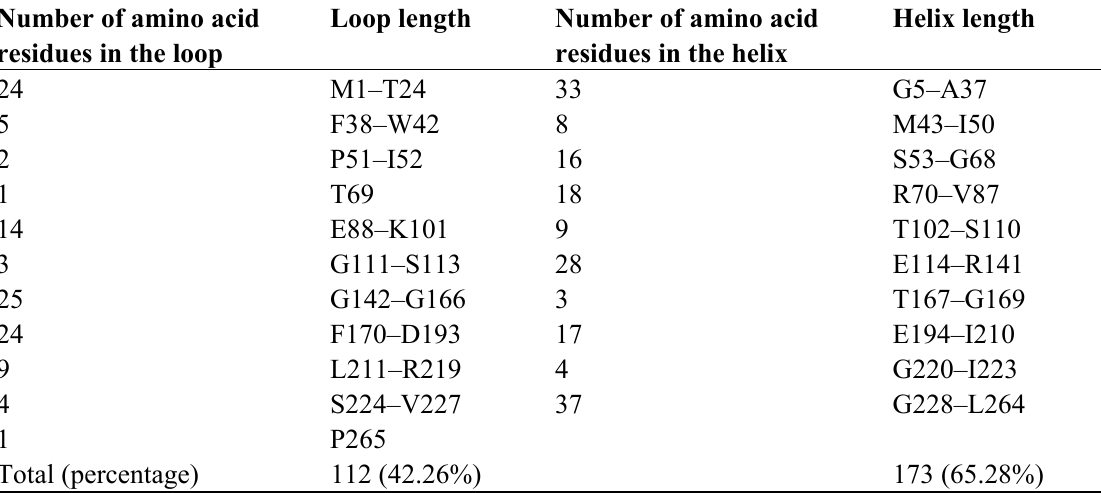
Table 1. Number and lengths of loops and helices in